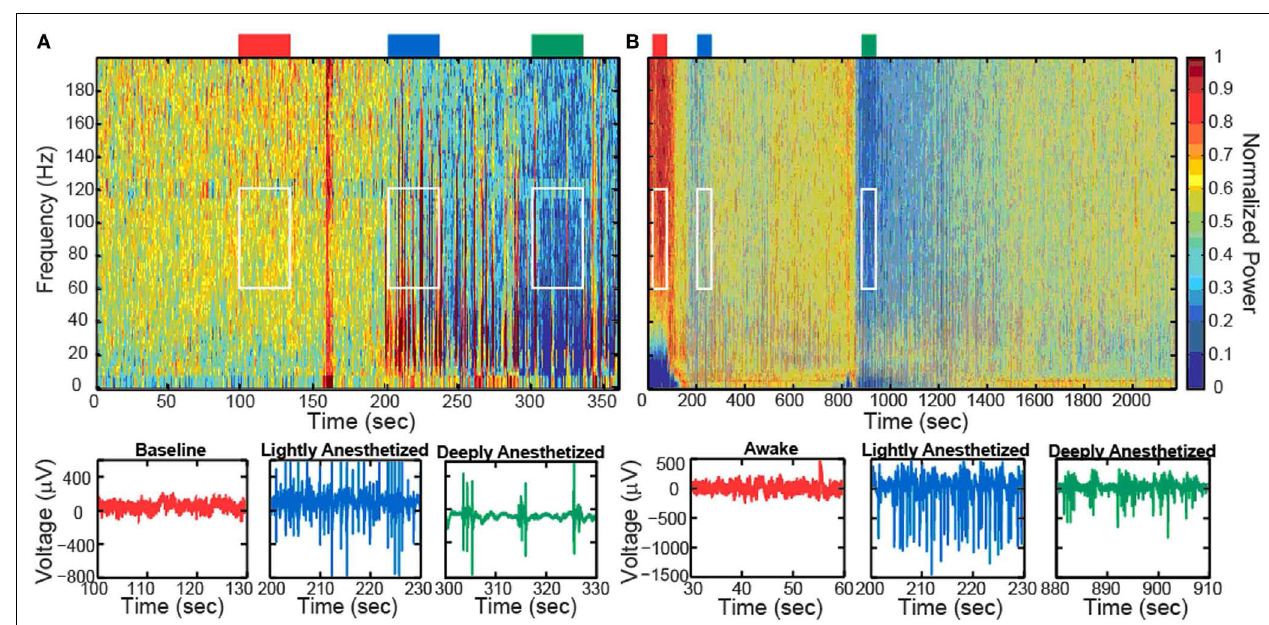
correspond with the level of anesthesia. Red represents the baseline or awake state. Blue represents the lightly anesthetized state. Green represents the deeply anesthetized state.White rectangles indicate the time periods and frequency bands chosen for the average power calculations across the array.